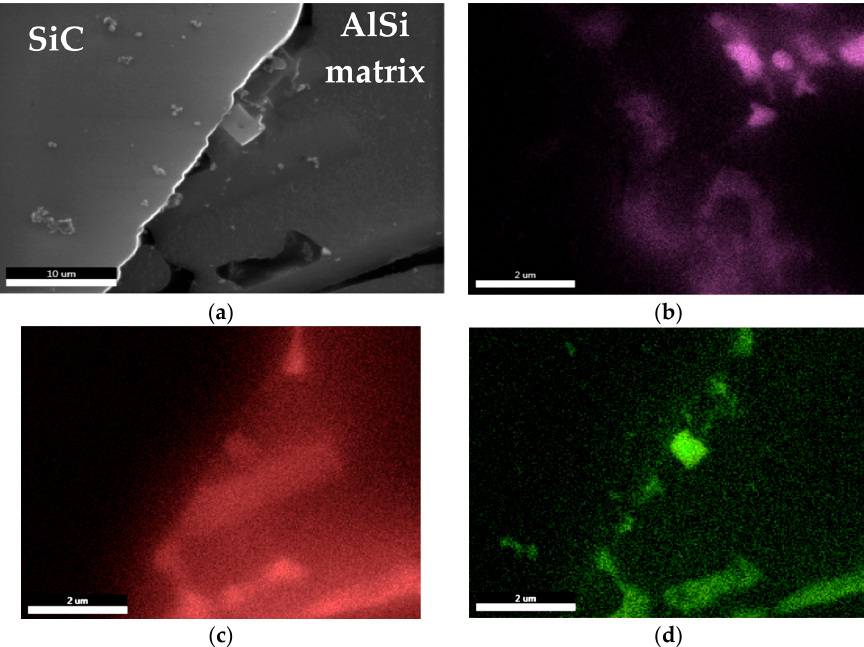
Figure 9. Surface distributions of elements at the interface between AlSi7Mg2Sr0.03 matrix alloy and SiC particles: ( a ) SEM image; ( b ) Sr K; ( c ) Mg K; ( d ) O K.